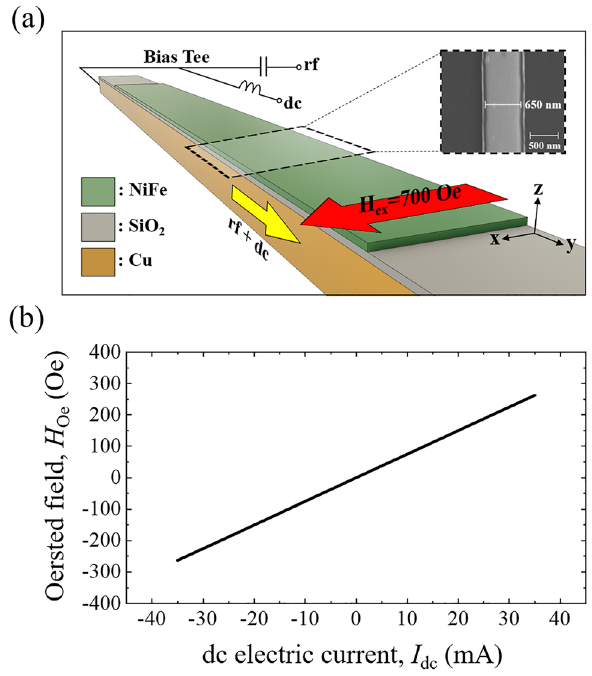
Figure 1. (a) Schematic diagram of a permalloy nanowire for parametric pumping. A global external field ( H ext ) of 700 Oe is applied along the x -axis. The inset presents an SEM image of the top surface in the x – y plane, showing the topology of the nanowire and the 650 nm width. (b) Calculated Oersted field along the x -axis as a function of the dc